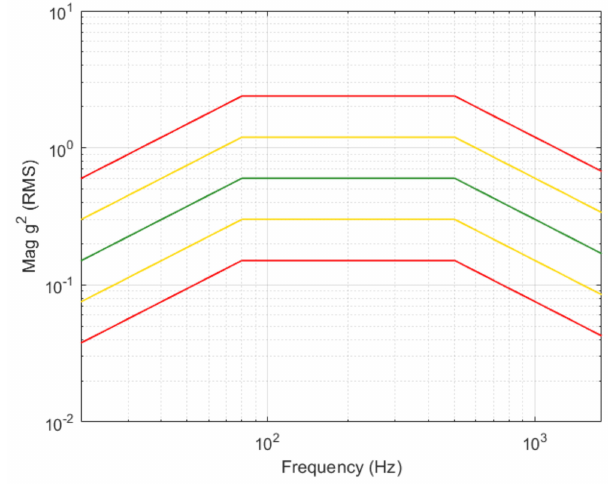
Figure 6. Random test